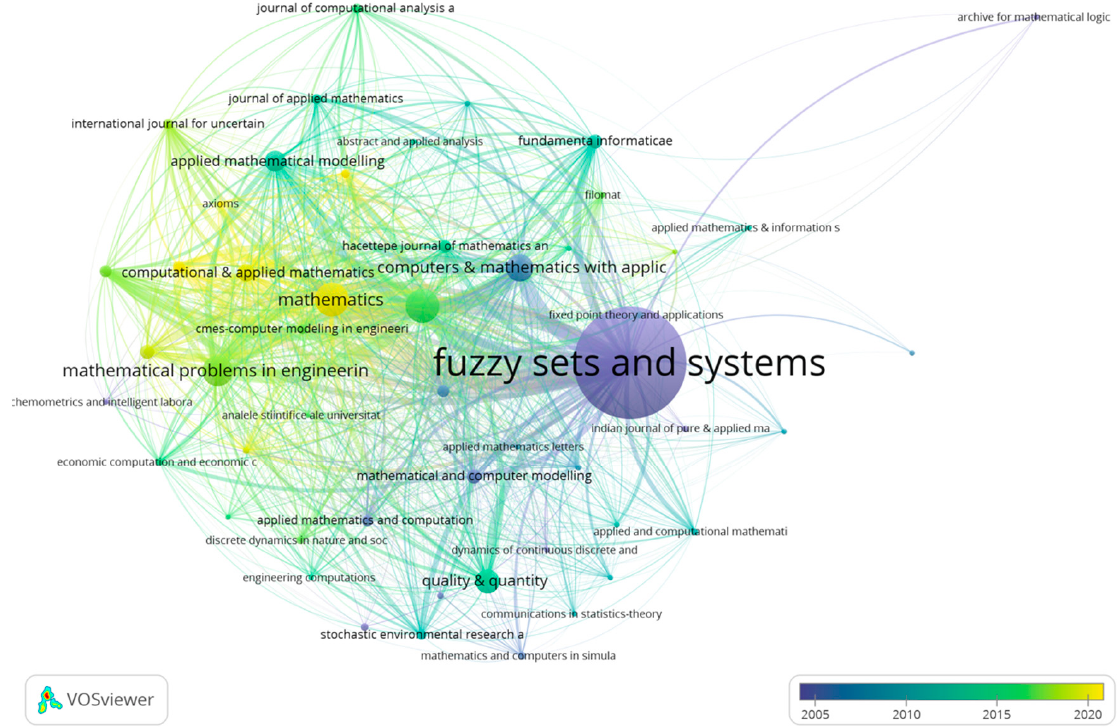
Figure 10. Bibliographic coupling for journals. Overlay visualization.